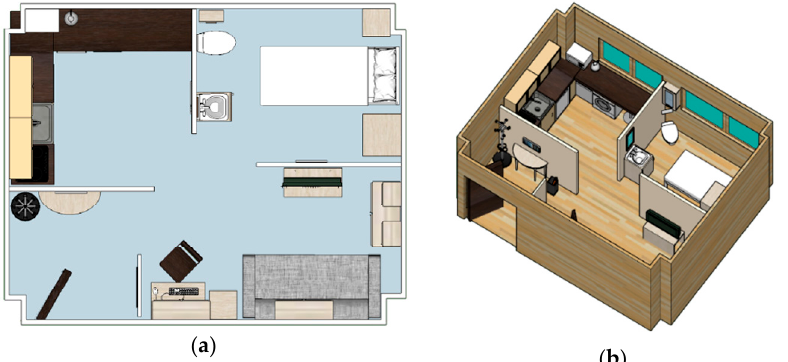
Figure 1. Layout of the UJAmI SmartLab ( a ) plan view ( b ) isometric view